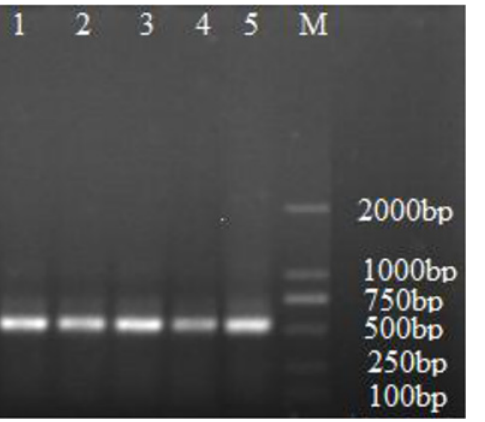
Fig 11. β -actin gene analysis of cDNA template by agarose gel electrophoresis. Lane M: DNA Ladder; Lane 1: Control; Lanes2~5: cDNA of the sample treated with 0.70 μ M, 1.40 μ M, 2.80 μ M and 5.60 μ M EM-d- Rha,